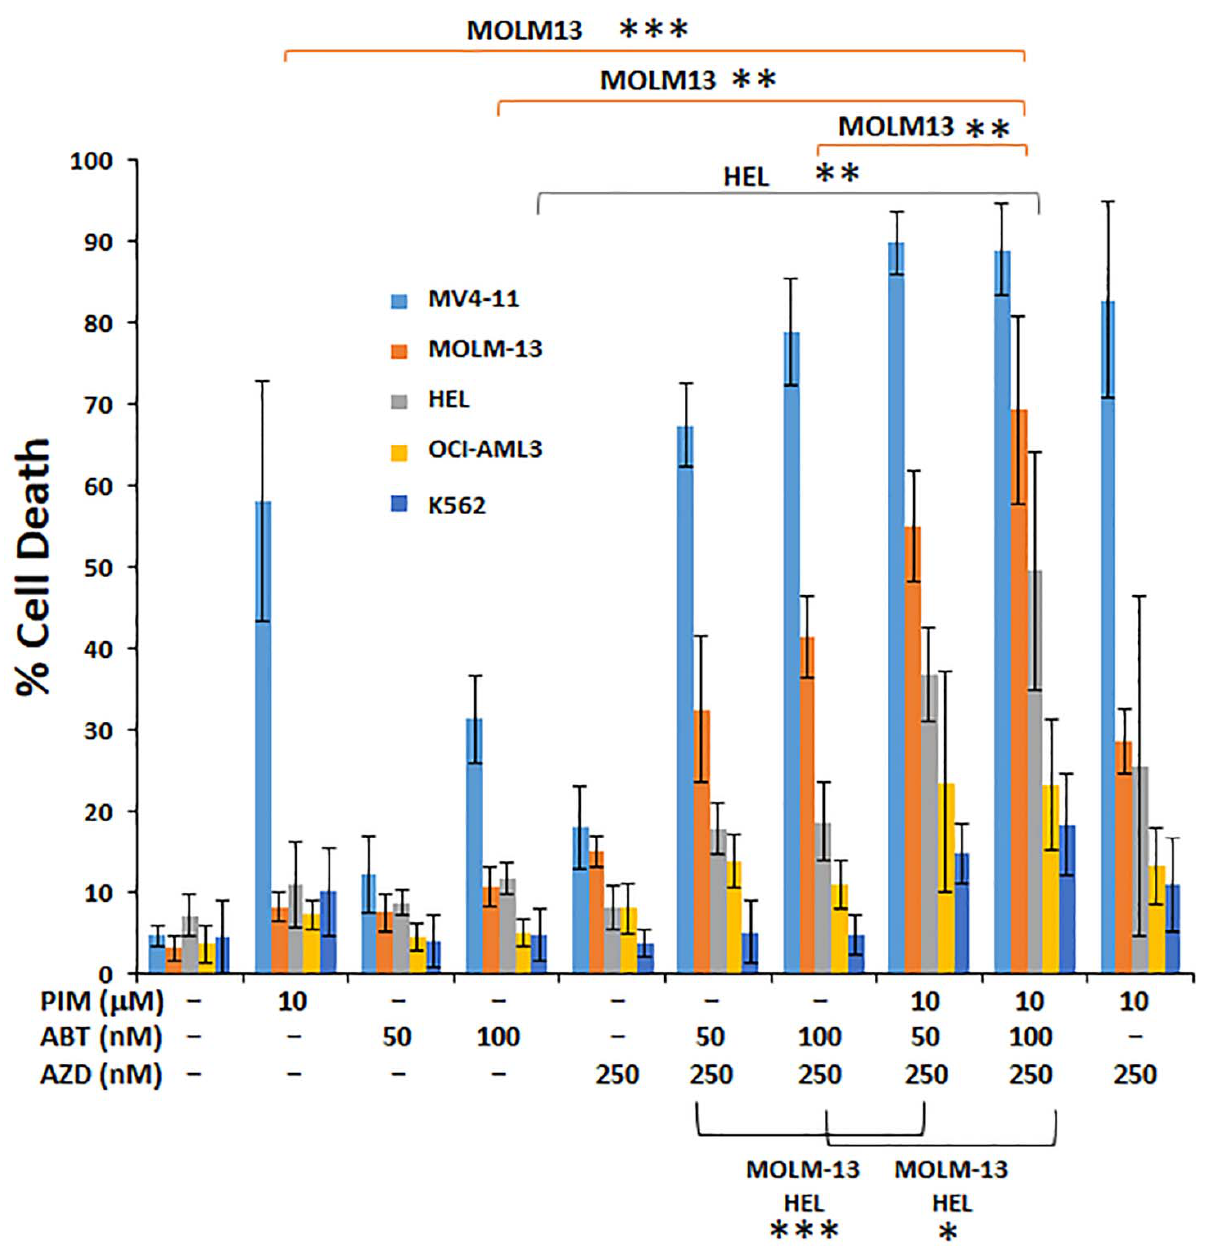
Figure 3. Triple combination treatment with ABT-263, AZD 8055, and pimozide selectively targets non-responders to single and dual combinations. Triple combination drug therapy after 48 h treatment is shown for cells treated with pimozide (PIM), ABT-263, and AZD 8055 (AZD). This combination was assessed in MOLM-13 and HEL cells to determine whether pimozide could effectively increase cell death determined by trypan blue exclusion assay compared with the ABT-AZD combination. n = 6 for all cell lines shown; p values were generated by comparing 2-drug vs. 3-drug combos as indicated. * p < 0.05; ** p < 0.01; *** p < 0.001.